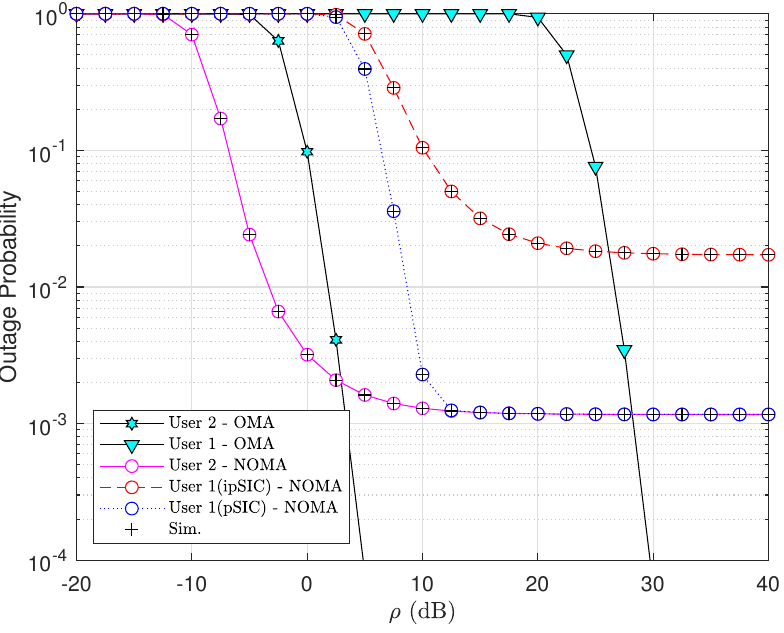
Figure 4. Comparison between NOMA-V2X and orthogonal multiple access (OMA)-V2X regarding outage performance of two vehicles with N = K = 3 and m =